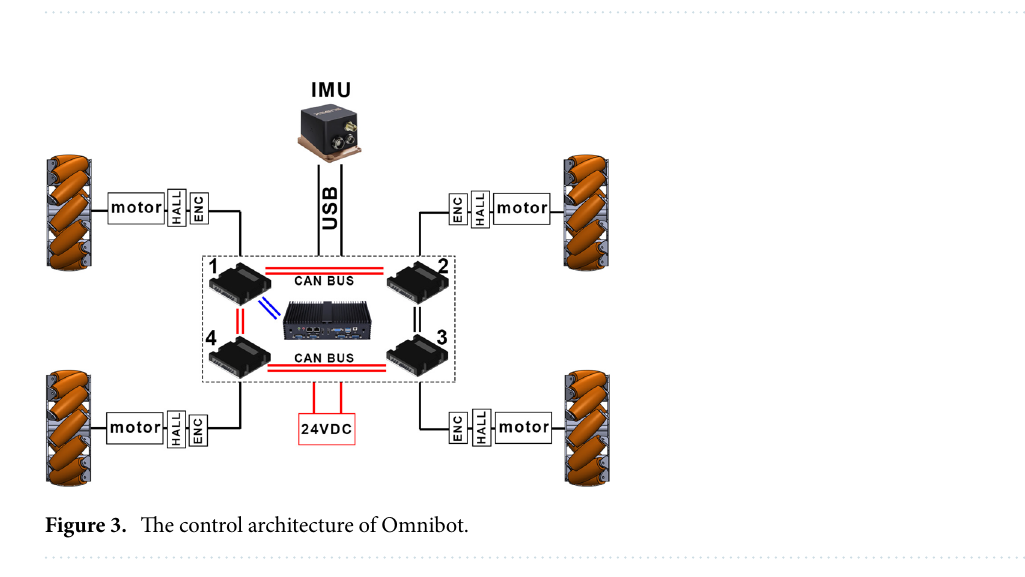
Figure 2. Details of the mecanum wheels: ( A ) side view; ( B ) isometric view, and ( C ) front view where it is possible to see the roller details. All measurements are in mm.